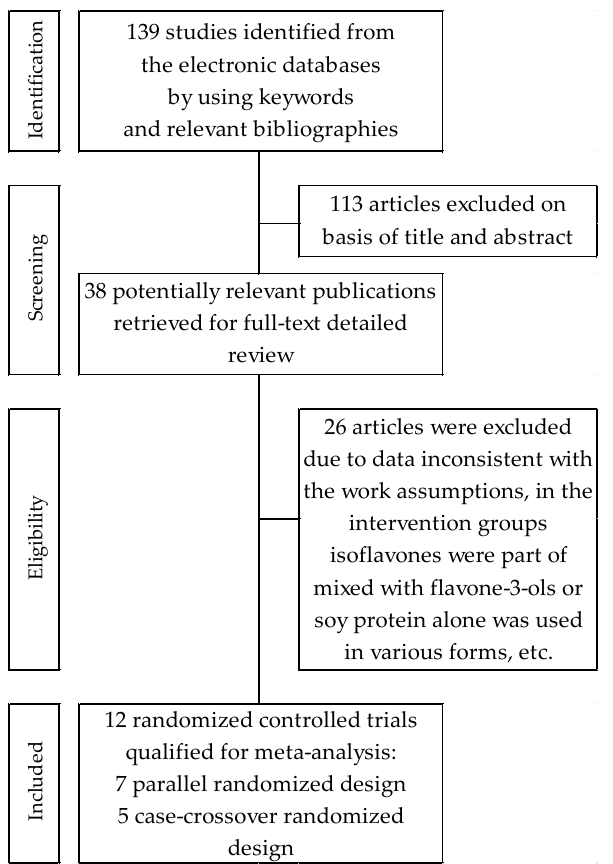
Figure 1. Flowchart of the selection procedure for studies included in the current review and me- ta-analysis.